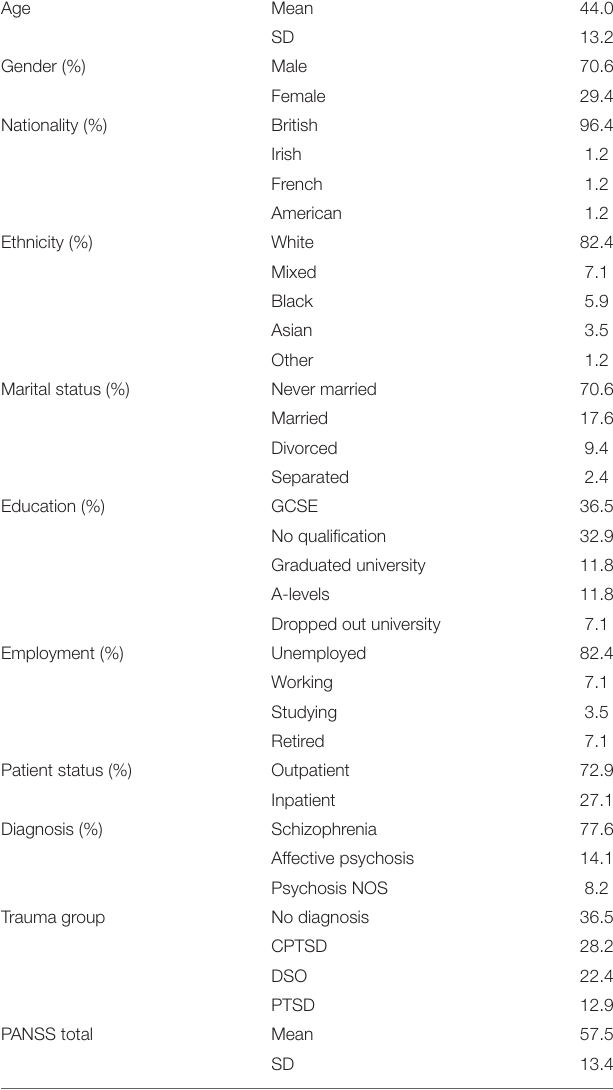
TABLE 1 | Demographic and clinical characteristics of the